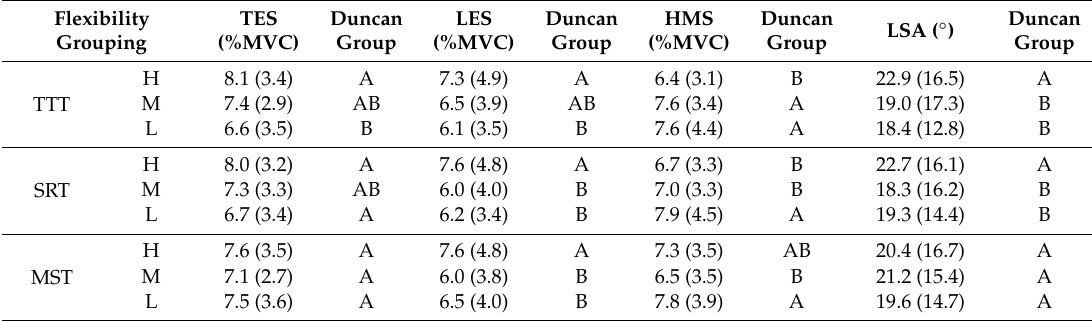
Figure 4. Alterations of the TES, LES and HMS muscles under varying trunk flexions (%MVC, percentage of MVC data). Table 6. Duncan grouping results for each variable under varying flexibility levels.